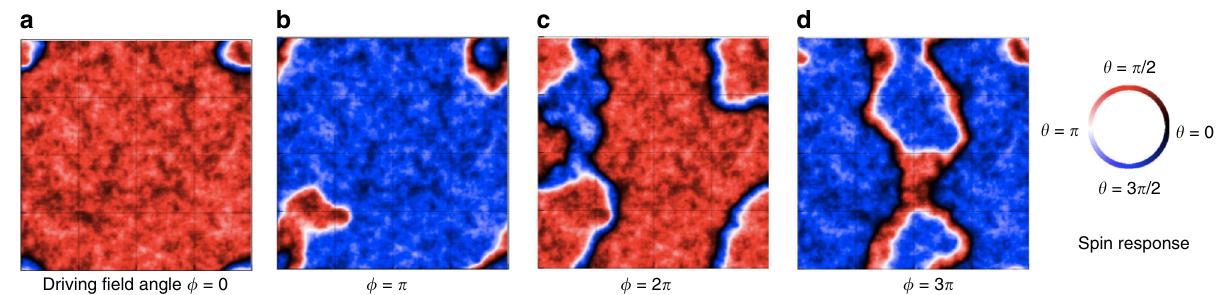
Fig. 4 Example of spin con fi gurations during a period-2 limit cycle at zero temperature. Spin con fi gurations a and c are for the same angle ϕ of the driving fi eld, but the spin con fi guration is different the second time through the driving cycle. Likewise, spin con fi gurations b and d are for the same angle ϕ of the driving fi eld, but the spin con fi guration is different the second time through the driving cycle. For this particular disorder con fi guration and system size, the spin con fi gurations repeat every 2 periods of the driving cycle. Here the driving fi eld strength is H = 0.04 J , and the system size is 160 × 160. See Fig. 1 of Supplementary Information and videos 22 of simulation results for further examples.